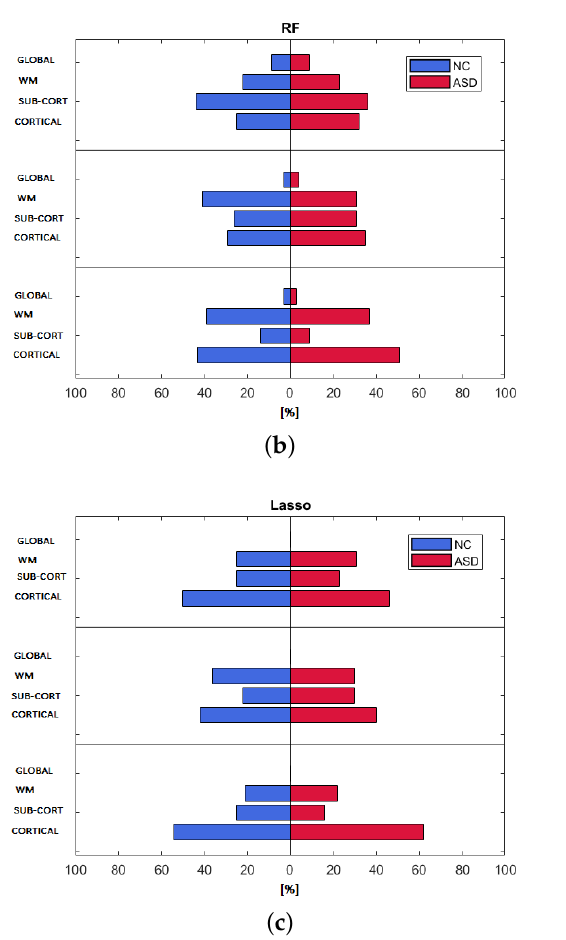
Figure 4. Frequency of occurrence of feature categories resulting from ( a ) SVR; ( b ) RF; ( c ) Lasso, for the three harmonization strategies and both populations.